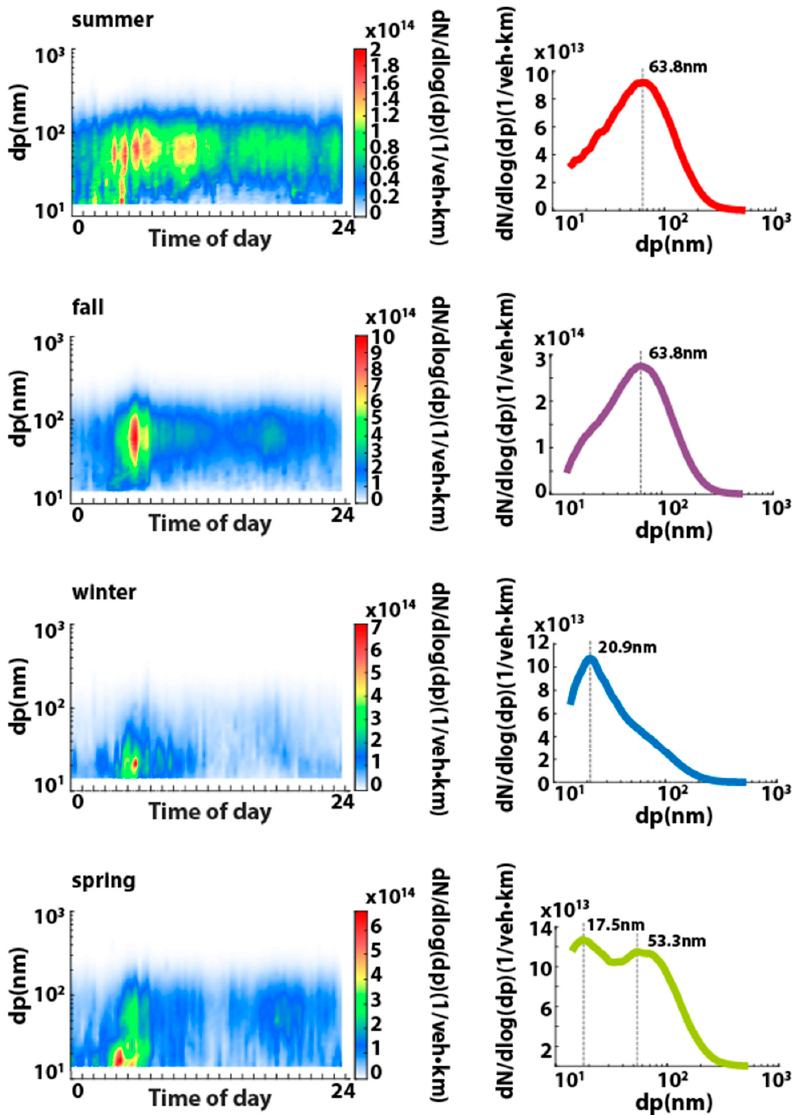
Figure 8. Time of daily evolution and overall average of vehicle emission rate of particle size distributions in each season.